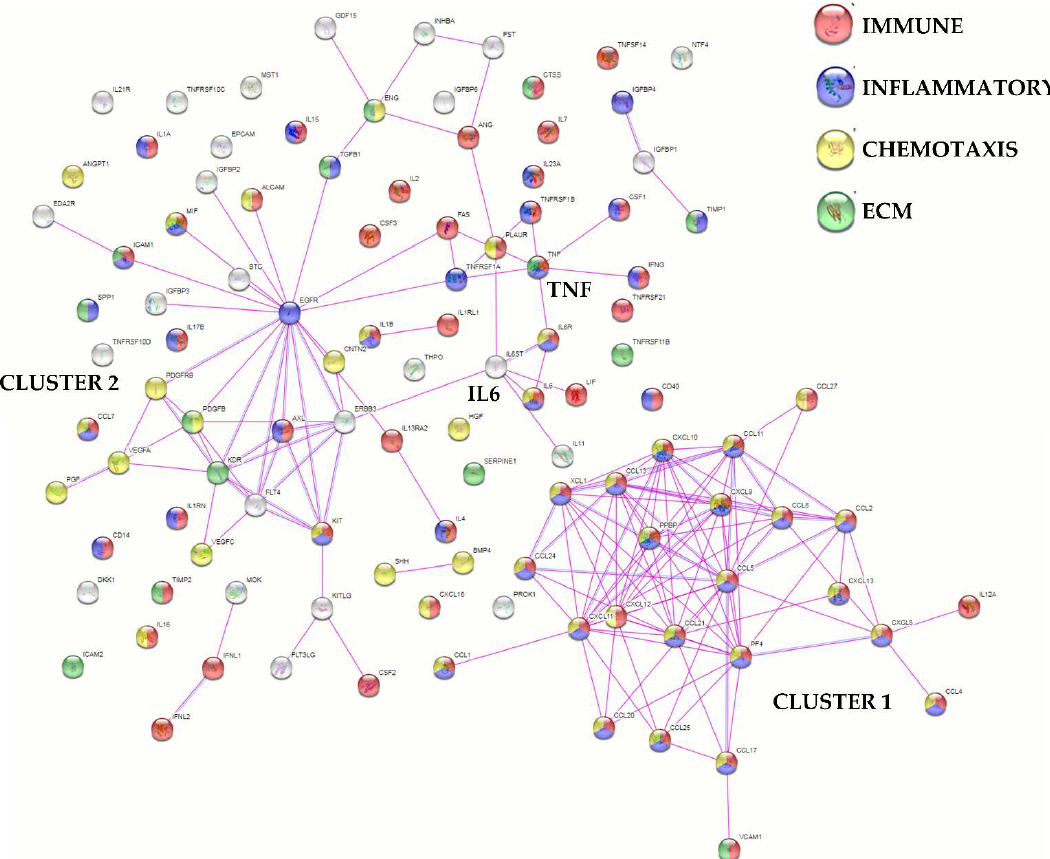
Figure 3. Functional association network for identified secreted factors. Protein–protein interaction levels for 111 proteins of the BMSCs secretome were mined using the online tool STRING. The blue connections are for proteins with known interactions based on curated databases; violet connections for proteins with experimentally determined interactions. Colorless nodes for proteins not related to the GO terms: immune, inflammatory, chemotaxis and ECM in the STRING database v 11.5. Empty nodes, proteins of unknown 3D structure; filled nodes, known or predicted 3D structure. Immune, inflammatory, chemotaxis and ECM-related GO terms are shown.